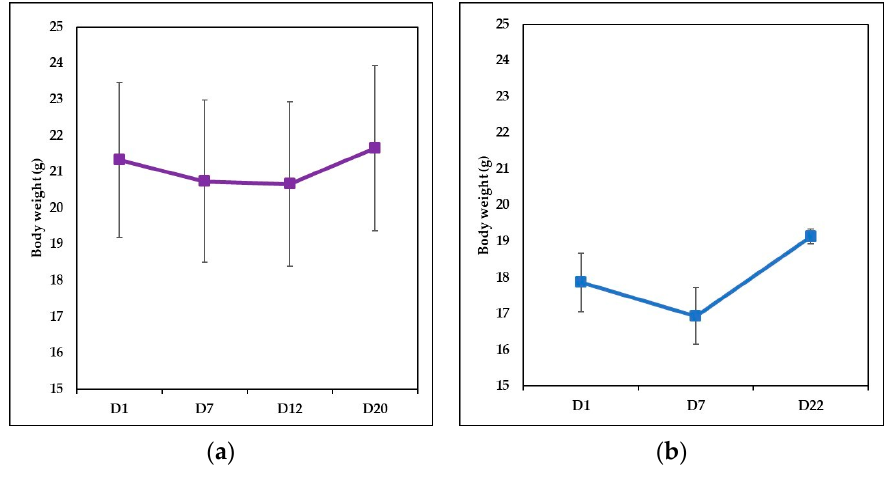
Figure 2. Evolution of the body weight ( a ) Evolution of the body weight for IgY-treated Ps group (n = 12)-day 1 (21.33 ± 2.14), day 7 (20.74 ± 2.24), day 12 (20.66 ± 2.27), day 20 (21.65 ± 2.28) ( b ) Evolution of the body weight for naturally remitted Ps group (n = 8)-day 1 (17.87 ± 0.81), day 7 (16.93 ± 0.78), day 22 (19.13 ± 0.21). The results are presented as mean ± SD; n = number of mice; D = day.